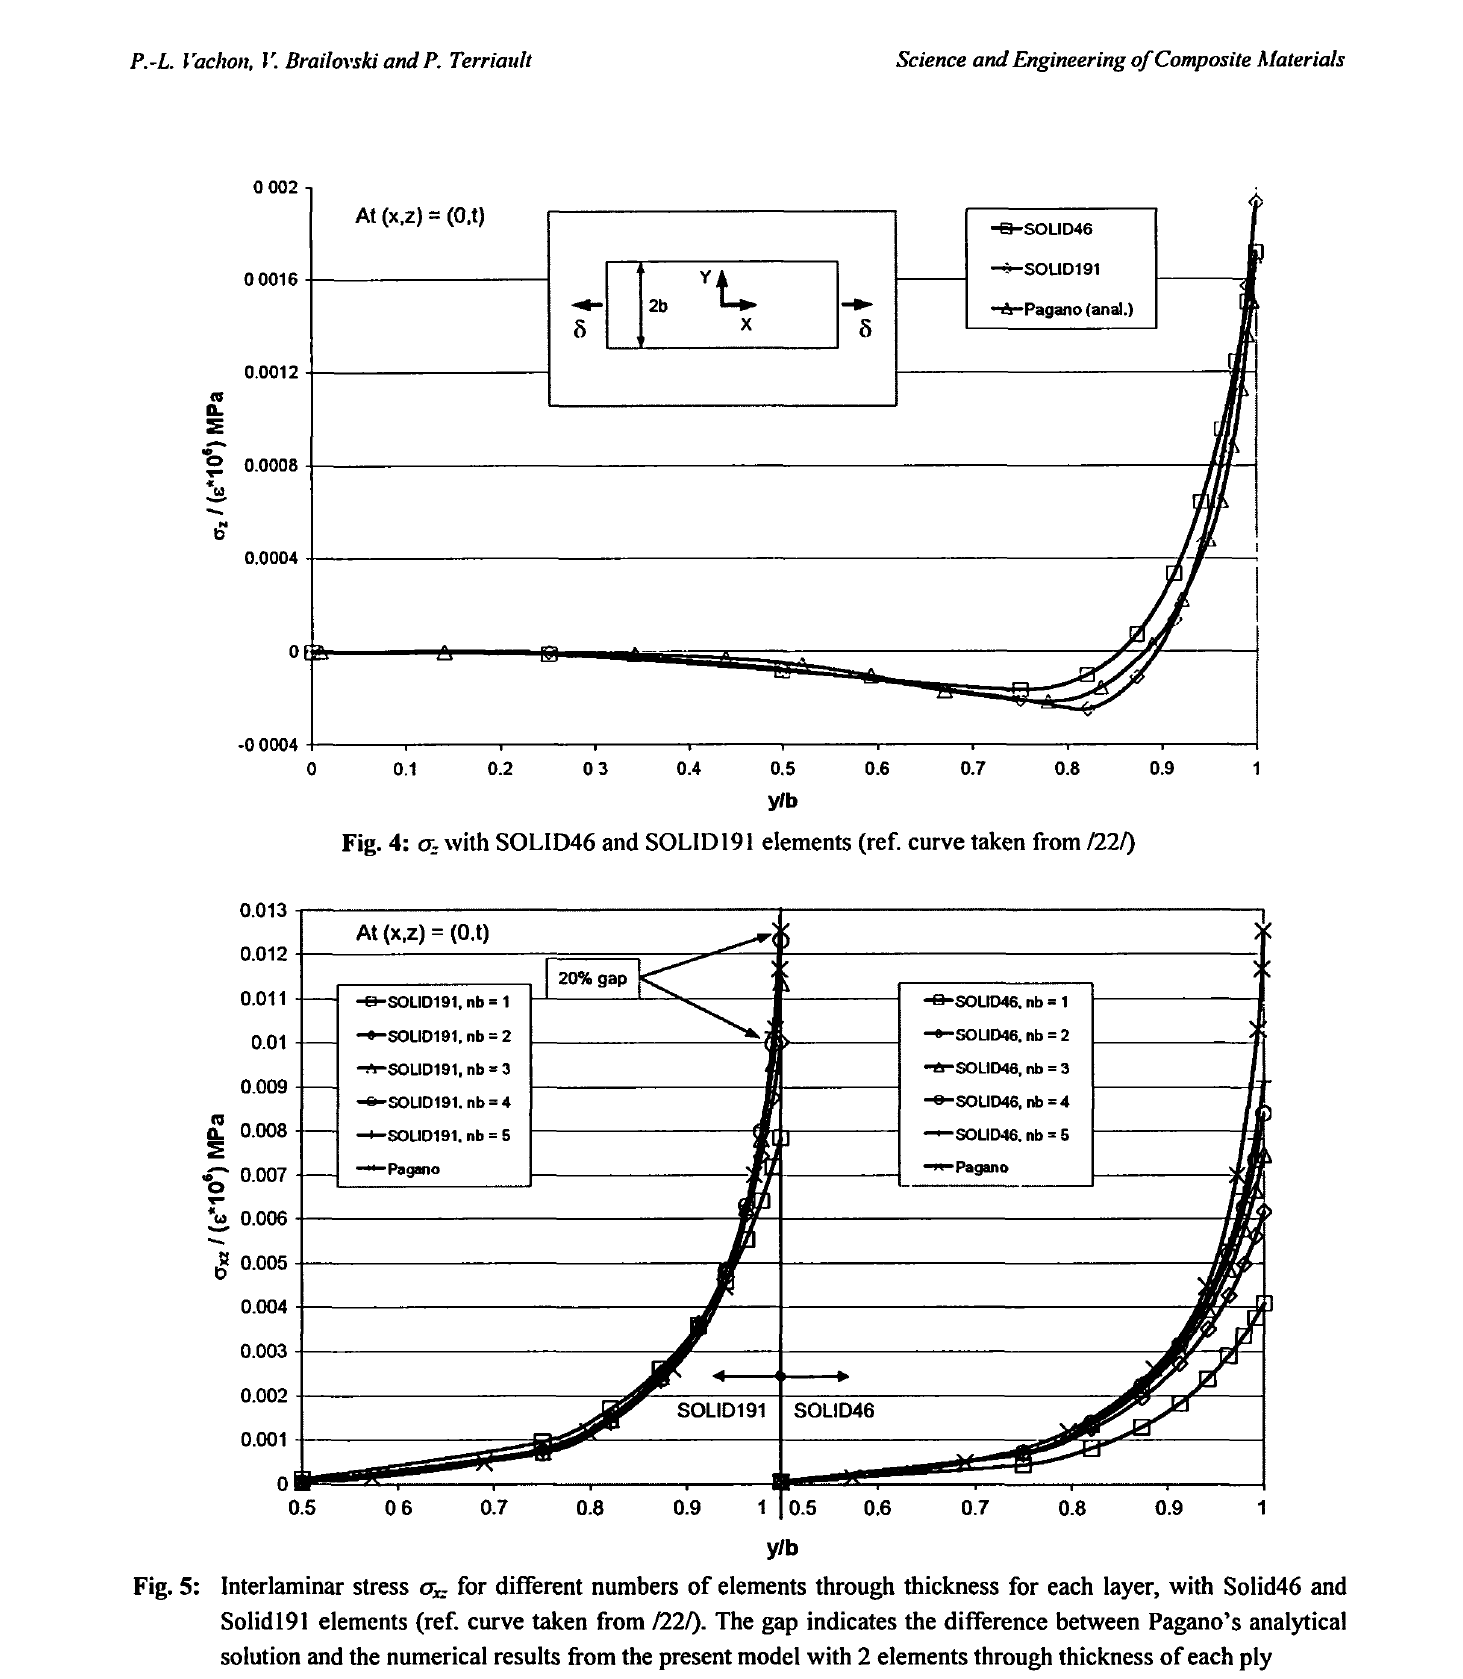
Fig. 4: σ- with SOLID46 and SOLID191 elements (ref. curve taken from Ι22Γ)